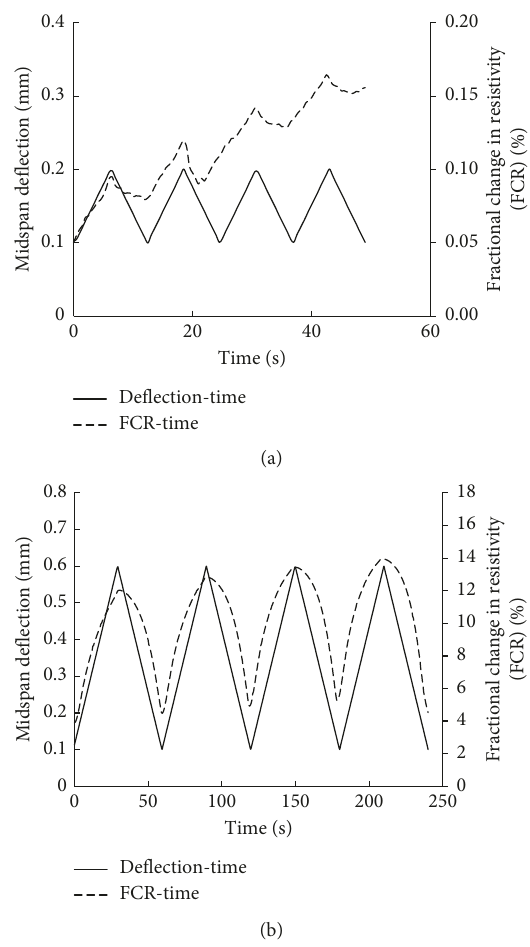
Figure 10: Self-sensing behavior of MWCNT-reinforced ECCs subjected to cyclic flexural loading. (a) 0.1-0.2 mm. (b)